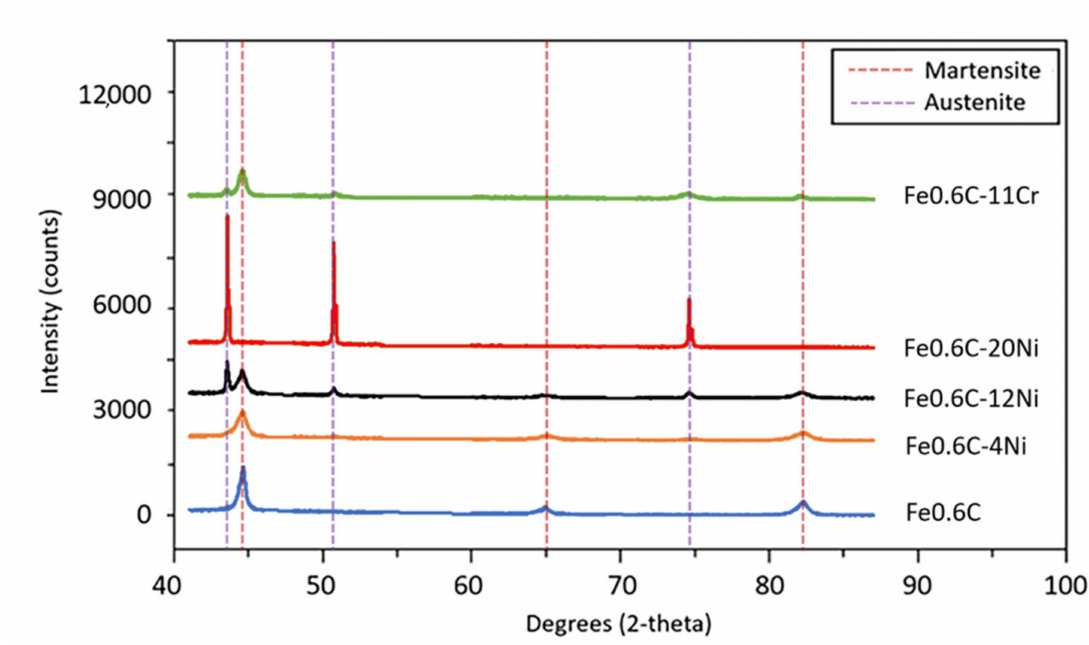
Figure A4. XRD di ff ractograms of selected alloys in as-quenched condition. Martensite and austenite peaks are indexed in the figure.